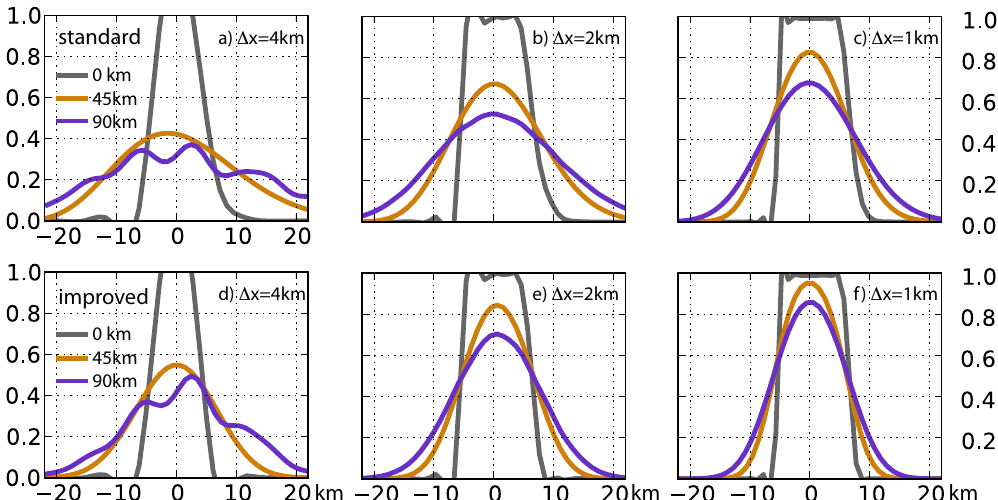
Fig. 5. Transport of fracture density as in Fig. 3 for different mesh sizes 4km, 2km and 1km (left to right) where the main flow direction is turned by 22.5 ◦ with respect to the underlying regular grid. Top panels show the results with the standard transport scheme; bottom panels show the ones done with the improved higher-accuracy